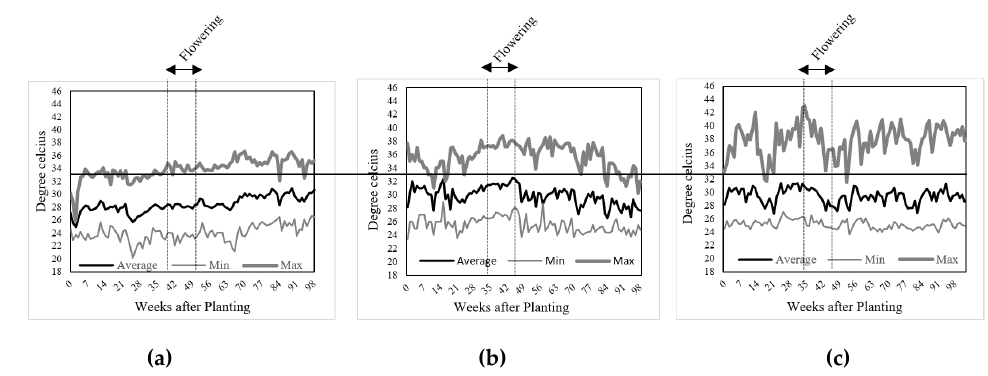
Figure 4. Temperature during the whole crop cycle of optimal temperature field ( a ), high temperature field ( b ), and high temperature greenhouse conditions ( c ). The solid line is a critical temperature at 33 ° C for tomato production.